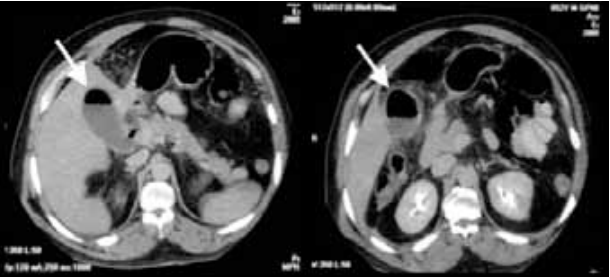
Fig. 1. Axial computed tomogram demonstrating the thick-walled gallbladder (arrow) which contains air. There is stranding in the surrounding mesenteric fat.